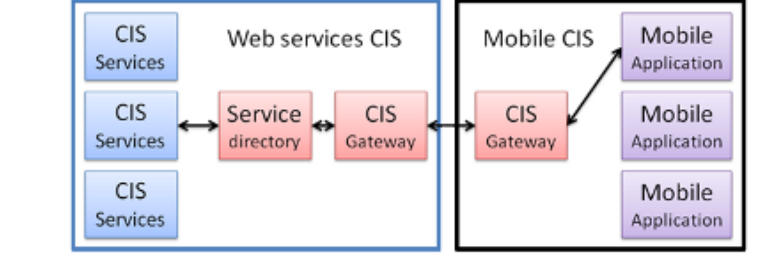
Figure 3. Communication architecture between mobile applications and existing